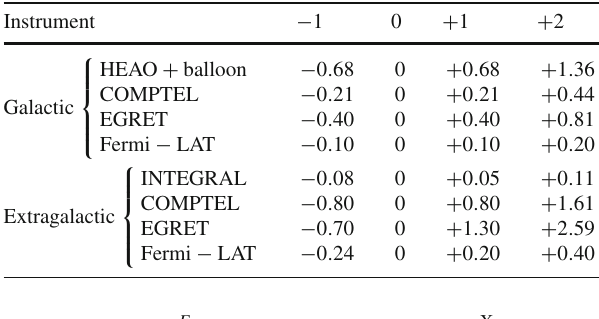
Table 1 Relative maximum increase in f PBH for CL = {− 1 , 0 , 1 , 2 } relative to the case CL = 0 for the instruments of Fig. 3